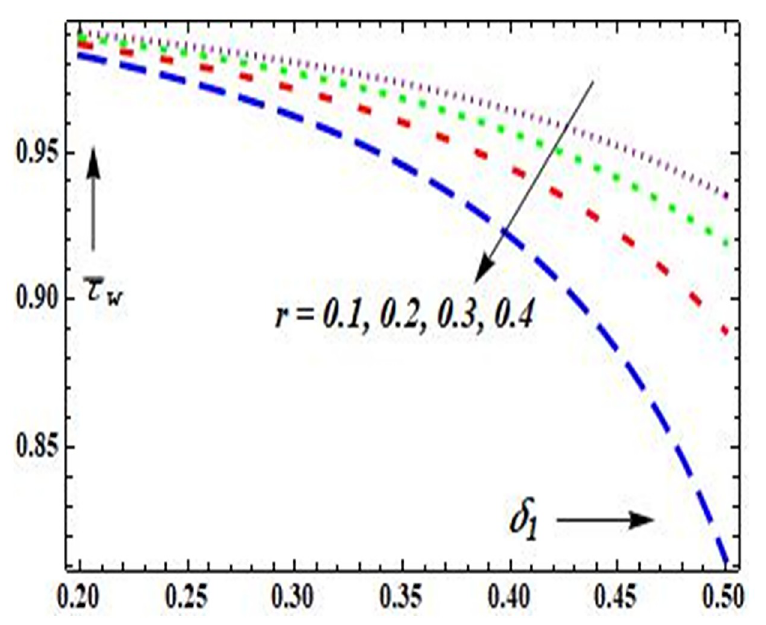
Fig 10. Plot of � τ